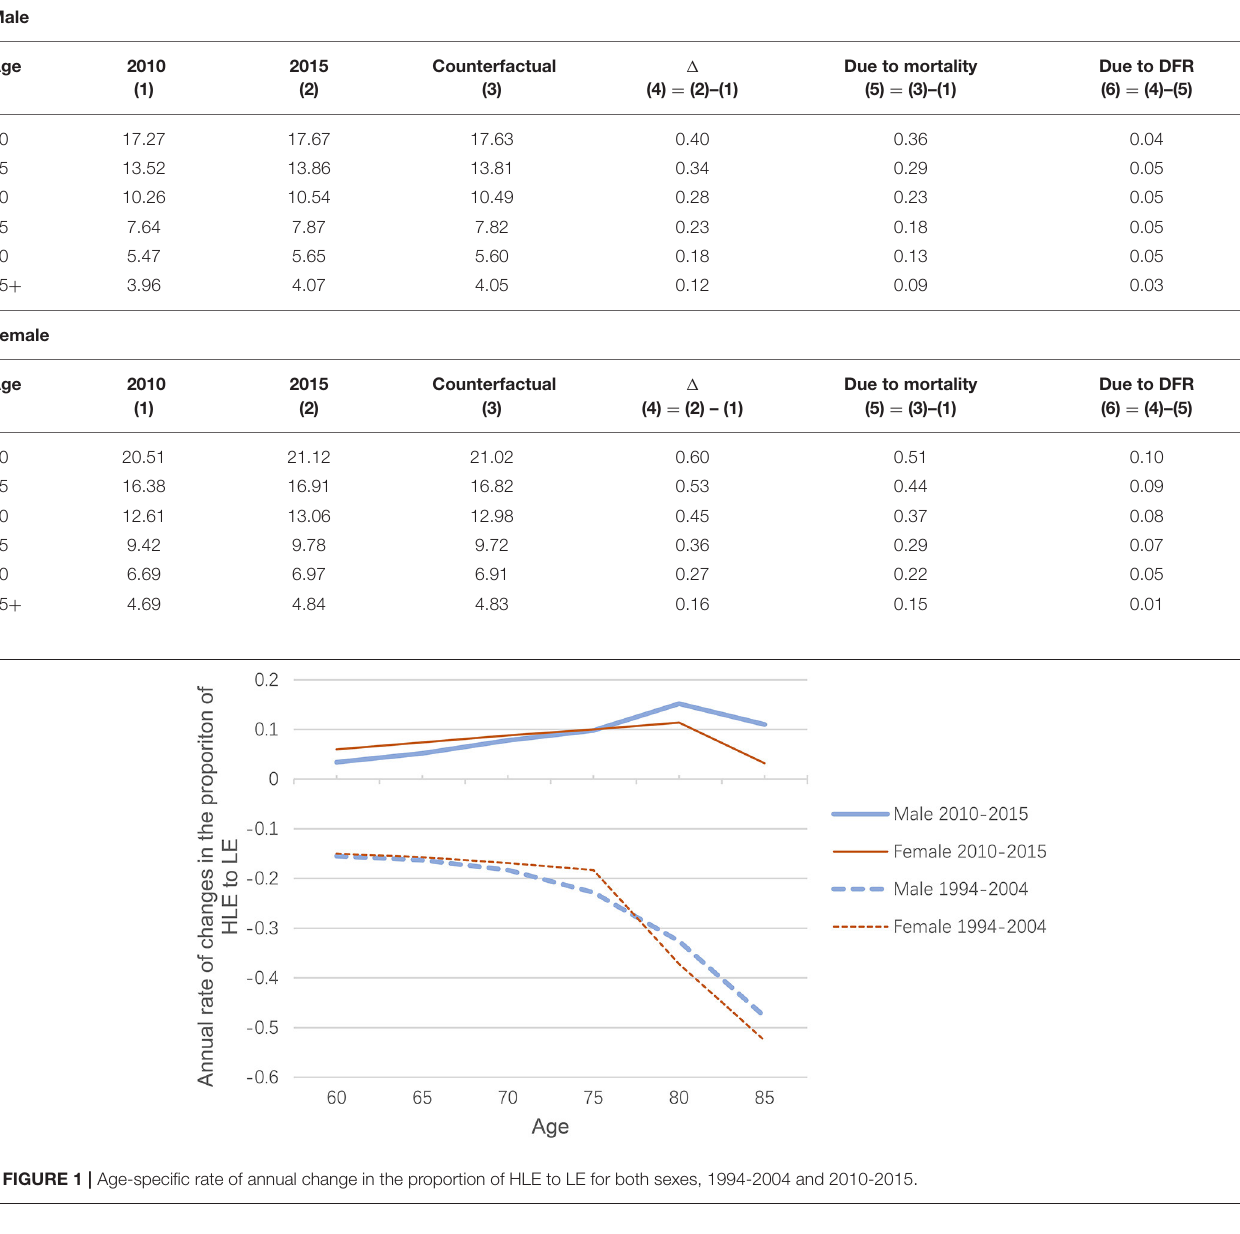
LE from 2010 to 2015 is much higher than the ratio from 1994 to 2004. The ratio of HLE to LE for females is the same case (red). In both periods, both sexes show similar rates of improvement in HLE relative to LE, as shown by the solid and dashed lines almost overlapping each